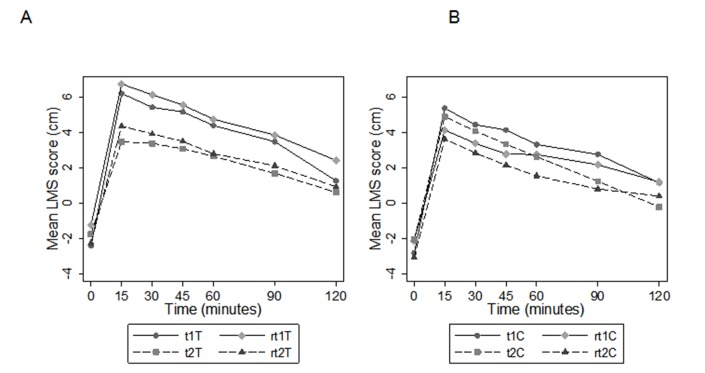
Post-prandial satiety responses (satiety score in cm over time) for each test and retest occasion (See Fig 1): A, training group (n = 12); B, no-training group (n = 11).